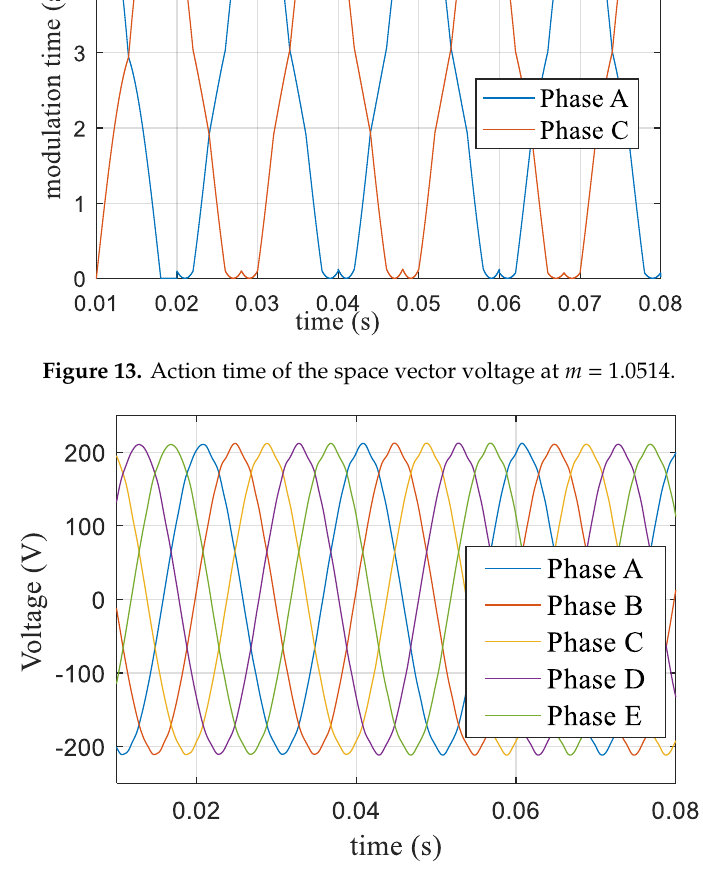
Figure 14. Five-phase voltage based on the new algorithm at m = 1.0514.